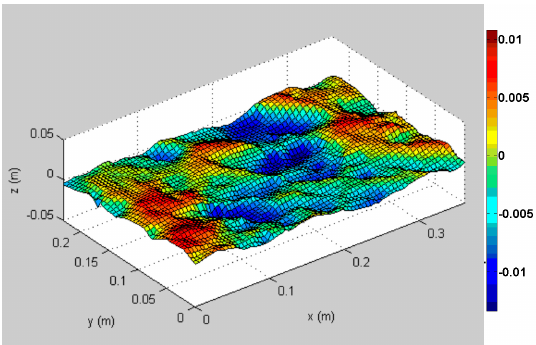
Figure 13. Reconstruction of instantaneous surface elevation from stereo imaging centered at x = 220 cm for wind velocity U max = 8.5 m / s. The color bar defines instantaneous local η in meters. Surface elevation variation with time at a fixed location, η ( x , y , t ), can be retrieved from the sequence of reconstructed 3D surfaces, as shown in Figure 13. The root mean square (RMS) values of the surface elevation η were computed at all wind velocities and fetches from a time series taken from the virtual wave gauges located across the central part of the reconstructed images. These records were compared in [66] with the wave-gauge results at an identical wind velocity and fetch (but not acquired simultaneously with the video imaging). Comparison of the two signals indicated that they have comparable wave heights and dominant frequencies; the records derived from the stereo imaging were usually somewhat noisier. Taking the wave gauge results as a reference, the (cid:2869)/(cid:2870) stereo imaging method overestimates 𝜂 (cid:2870) (cid:3364)(cid:3364)(cid:3364) by up to 30% at low wind velocities and thus small wave amplitudes; however, for stronger winds and longer fetches resulting in the surface elevation